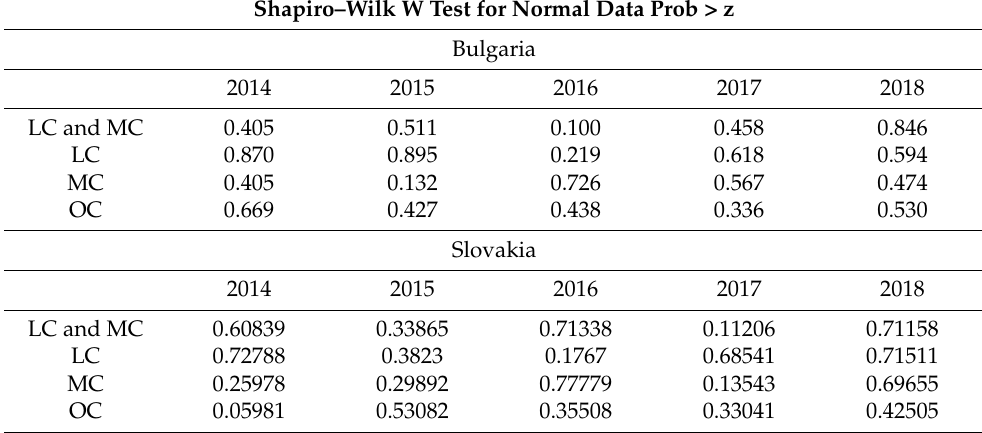
Table 3. Empirical probabilities of Shapiro–Wilk W test, α =